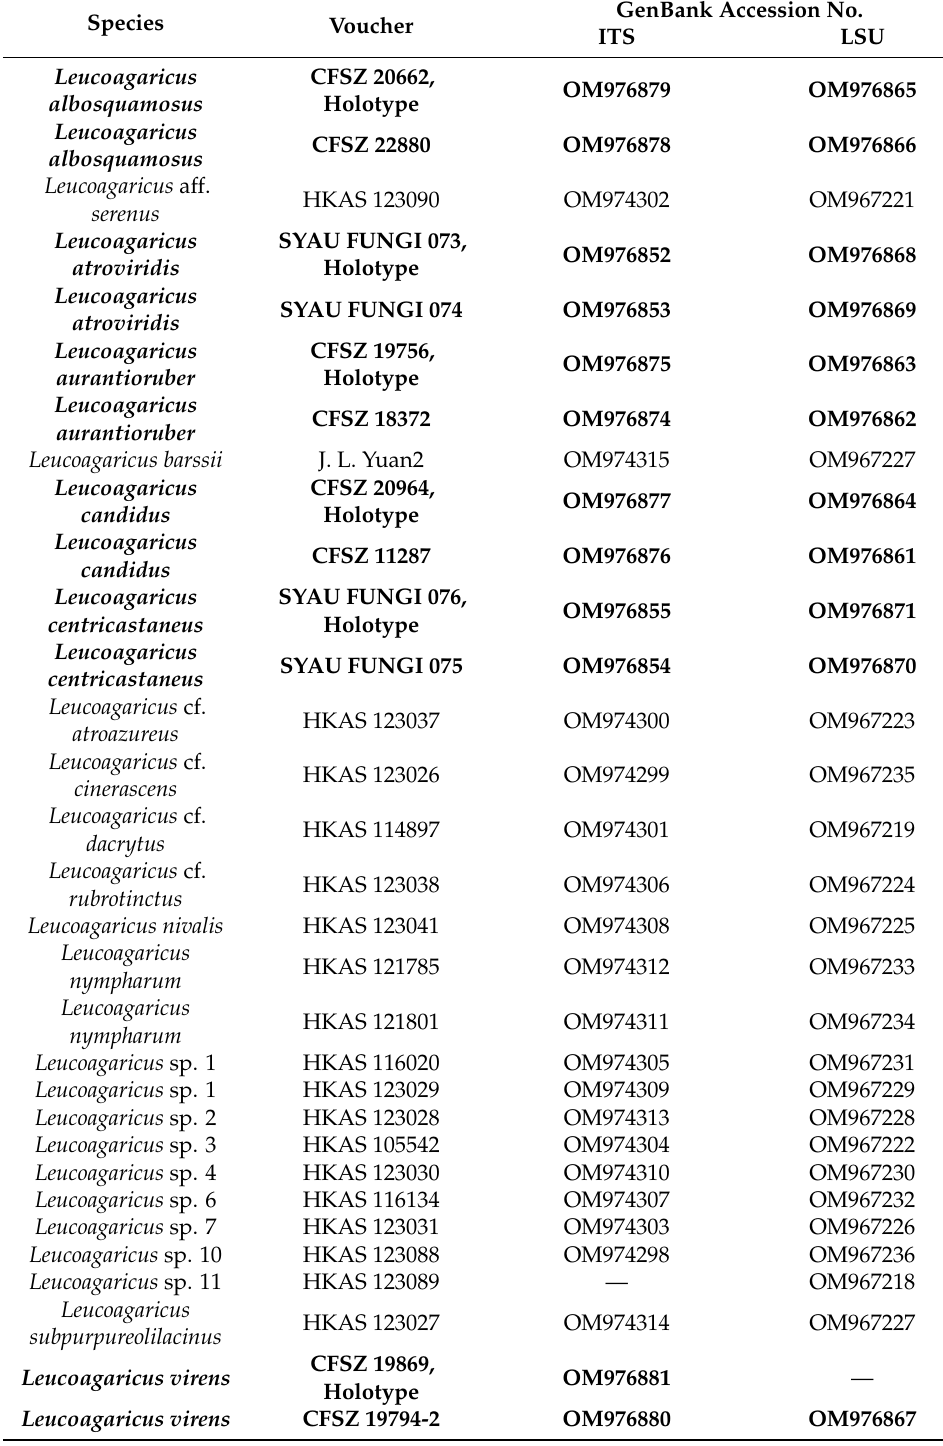
Table 1. Sequences of Leucoagaricus newly generated in this study; sequences generated from new species are shown in